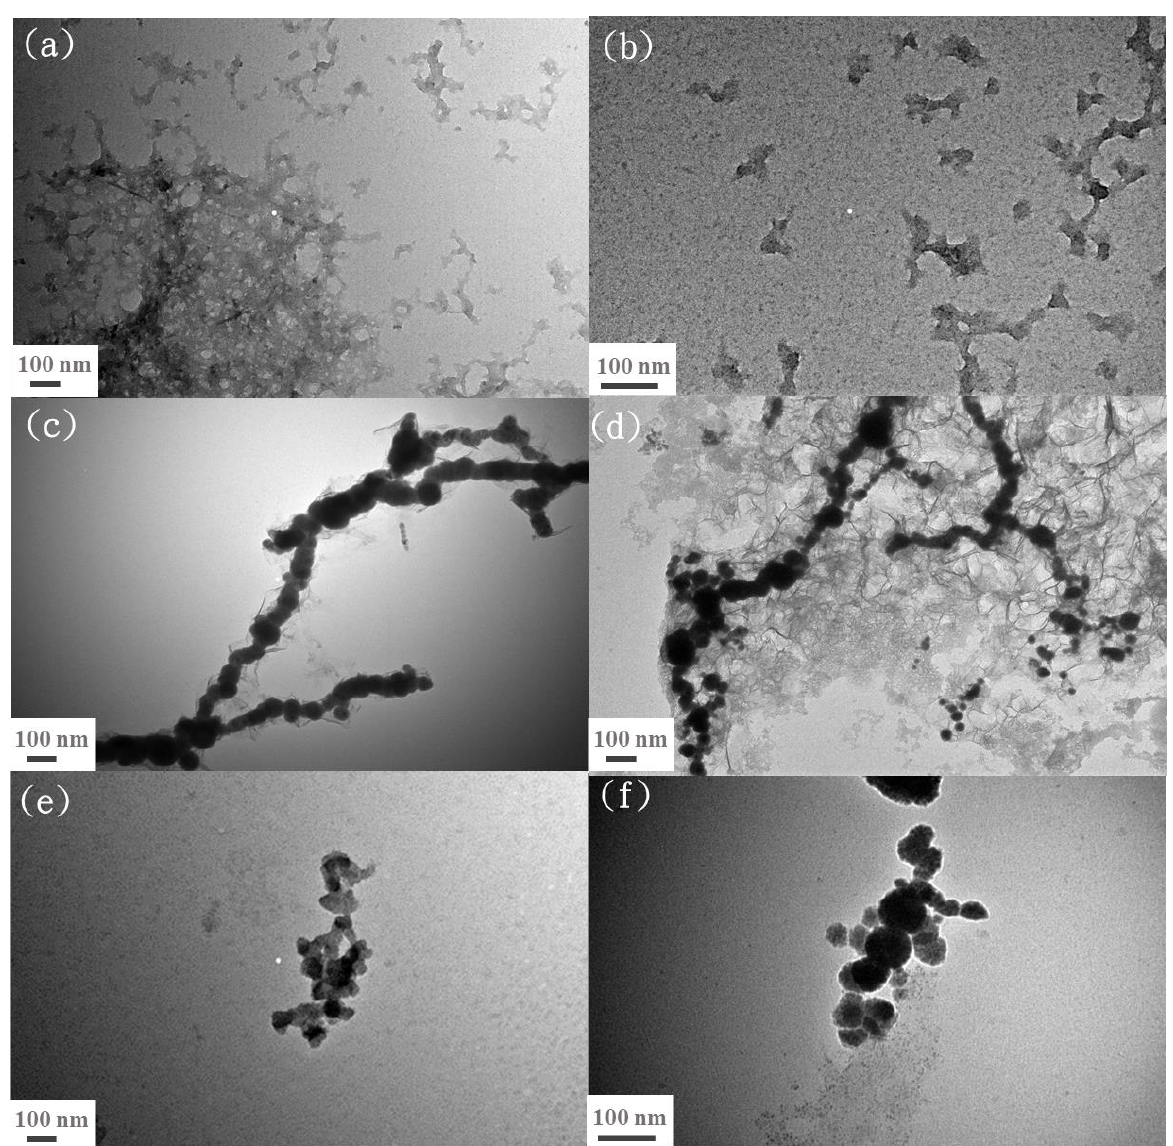
Figure 3. TEM images: ( a ) nanoscale lignin at a magnification of 100,000 × , ( b ) nanoscale lignin at a magnification of 200,000 × ( c ) bare nZVI at a magnification of 100,000 × , ( d ) EG-functionalized nZVI at a magnification of 100,000 × , ( e ) nZVI/n-lignin at a magnification of 100,000 × , and ( f ) nZVI/n-lignin at a magnification of 200,000 ×